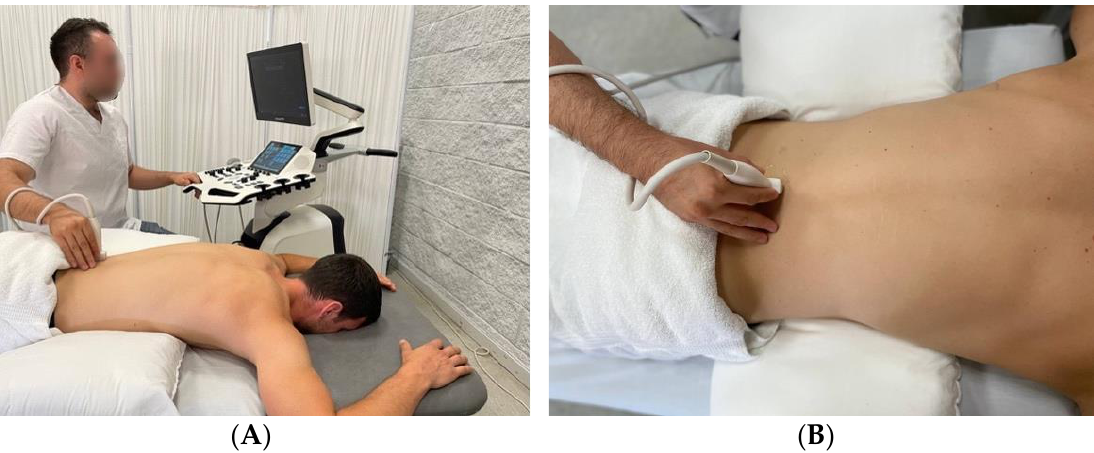
Figure 1. Ultrasound imaging sampling setting. ( A ) Patient lying prone, sonographer close to the patient and the ultrasound machine; ( B ) detailed image with the probe parasagittal over the lamina. The ultrasound measurements were made by a VINNO E35 ultrasound device with a linear 5–13 MHz probe and a 48 mm footprint.